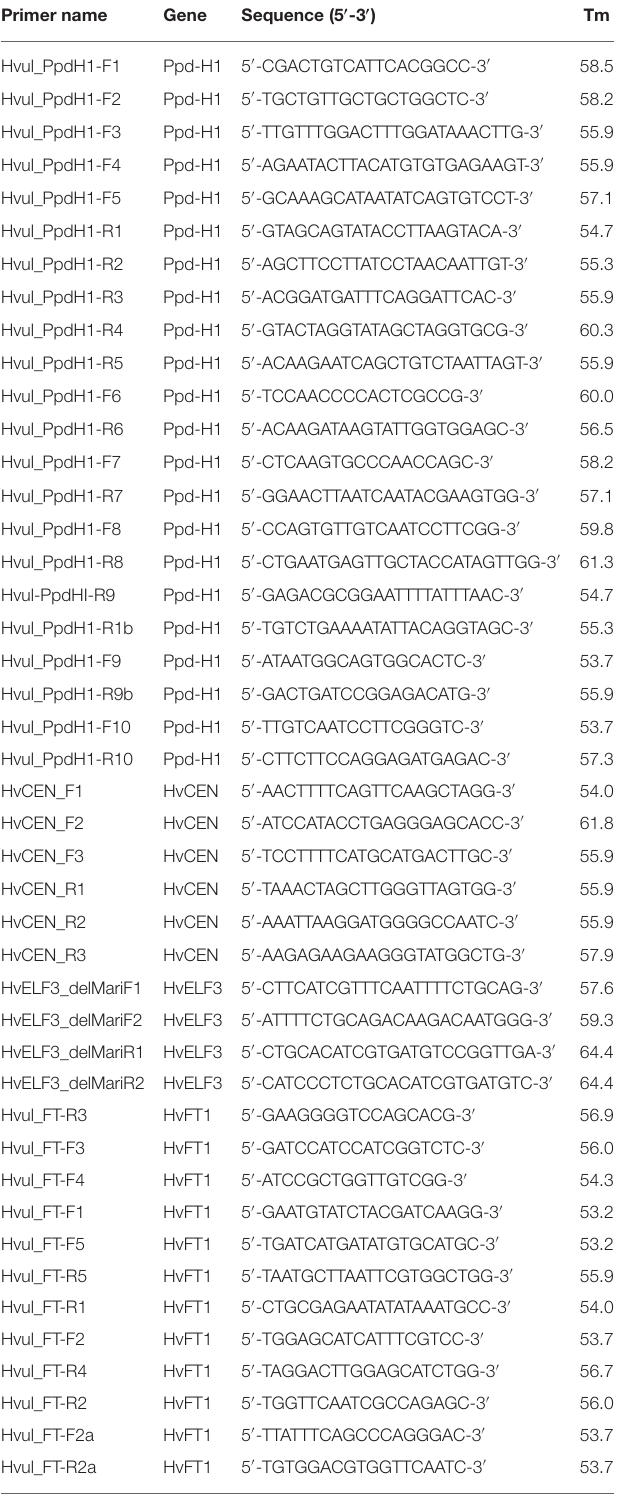
TABLE 2 | Primer names and sequences used for re-sequencing four flowering genes, along with their annealing temperature (Tm).